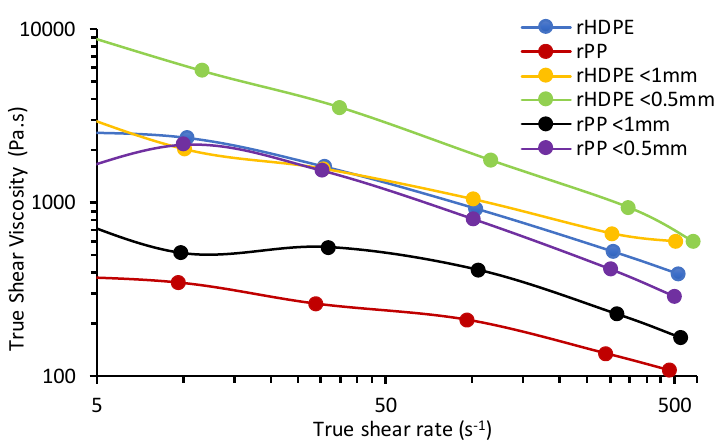
Figure 9. Flow curves of true shear viscosity versus true shear rate by capillary rheology of polyolefins and rice hull composites. Table 4. Melt flow and Rheology results for polyolefins and rice hull composites.